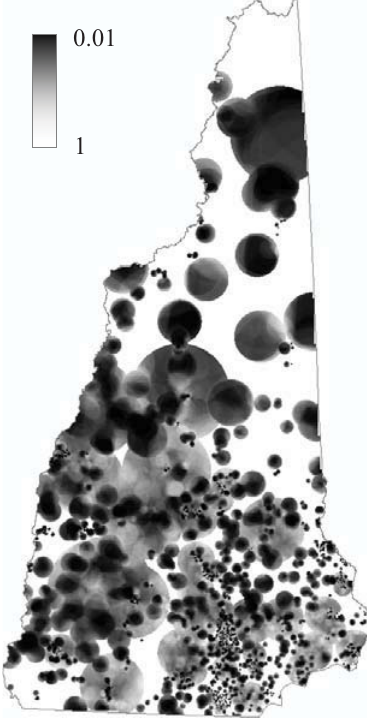
Figure 2. Spatial distribution of ( a ) birth defect intensity, and ( b ) its p-value in New